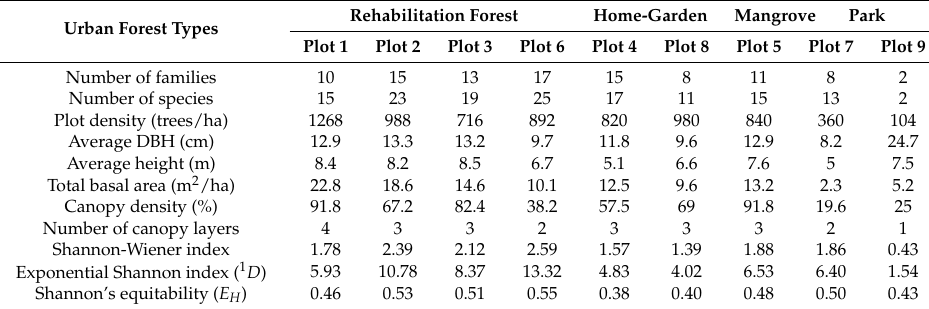
0.53 0.51 0.55 0.38 0.40 0.48 0.50